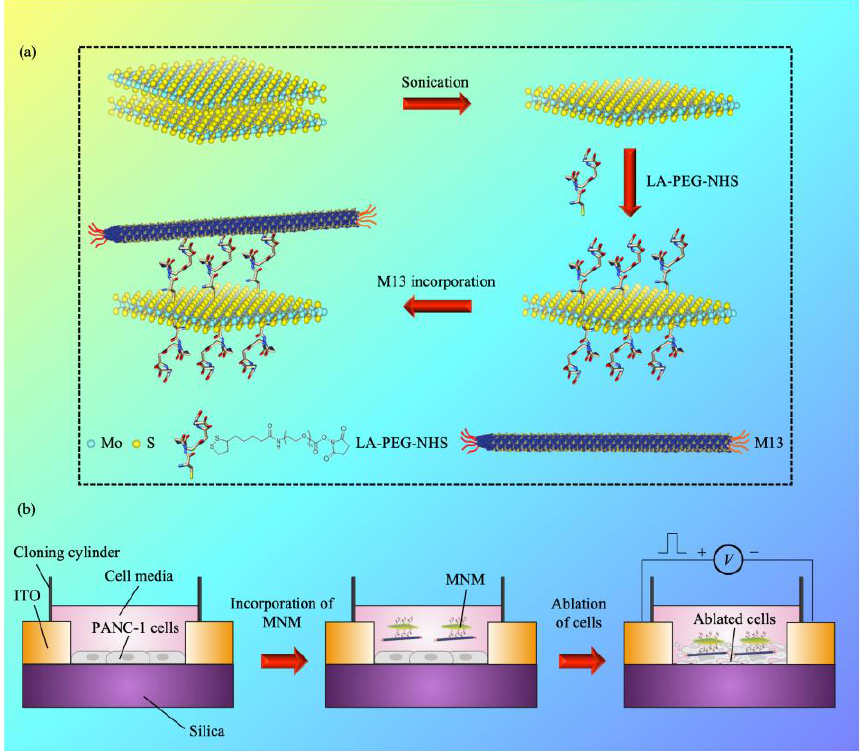
Figure 1. An AC-stimulus cancer cell platform based on MNM. ( a ) The bindings/reactions between the MoS 2 /M13 phage and the PEG molecules are illustrated. The schematic illustration was adapted and modified from [48]. ( b ) The MNM is incorporated in the AC-stimulus PANC-1 cancer cell system for cancer cell ablation and electrothermal therapy.